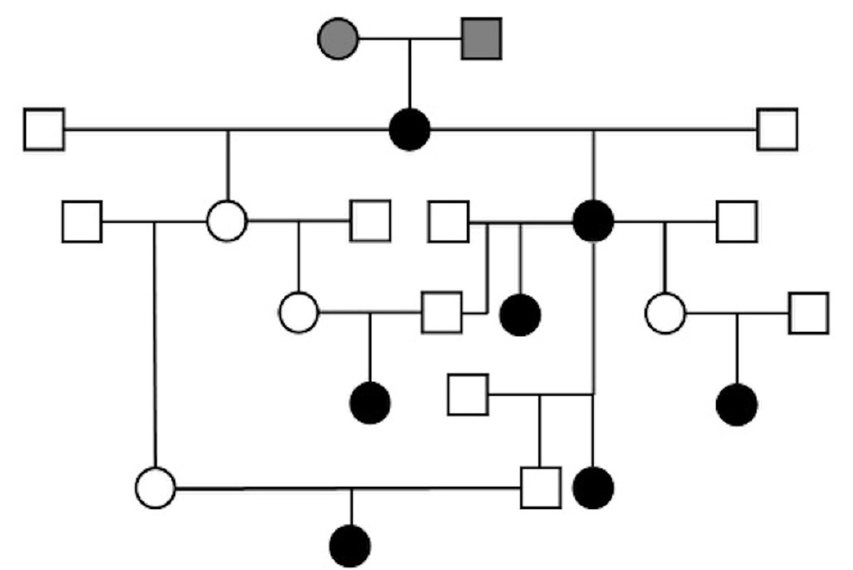
Figure 2. Composite pedigree of 7 female Boxer dogs affected by glomerular immaturity. The affected dogs had a common female and male mating (gray filled-in circle and square, respectively), shown at the top of the pedigree. Black circle—affected female; open square—untested male; open circle—untested